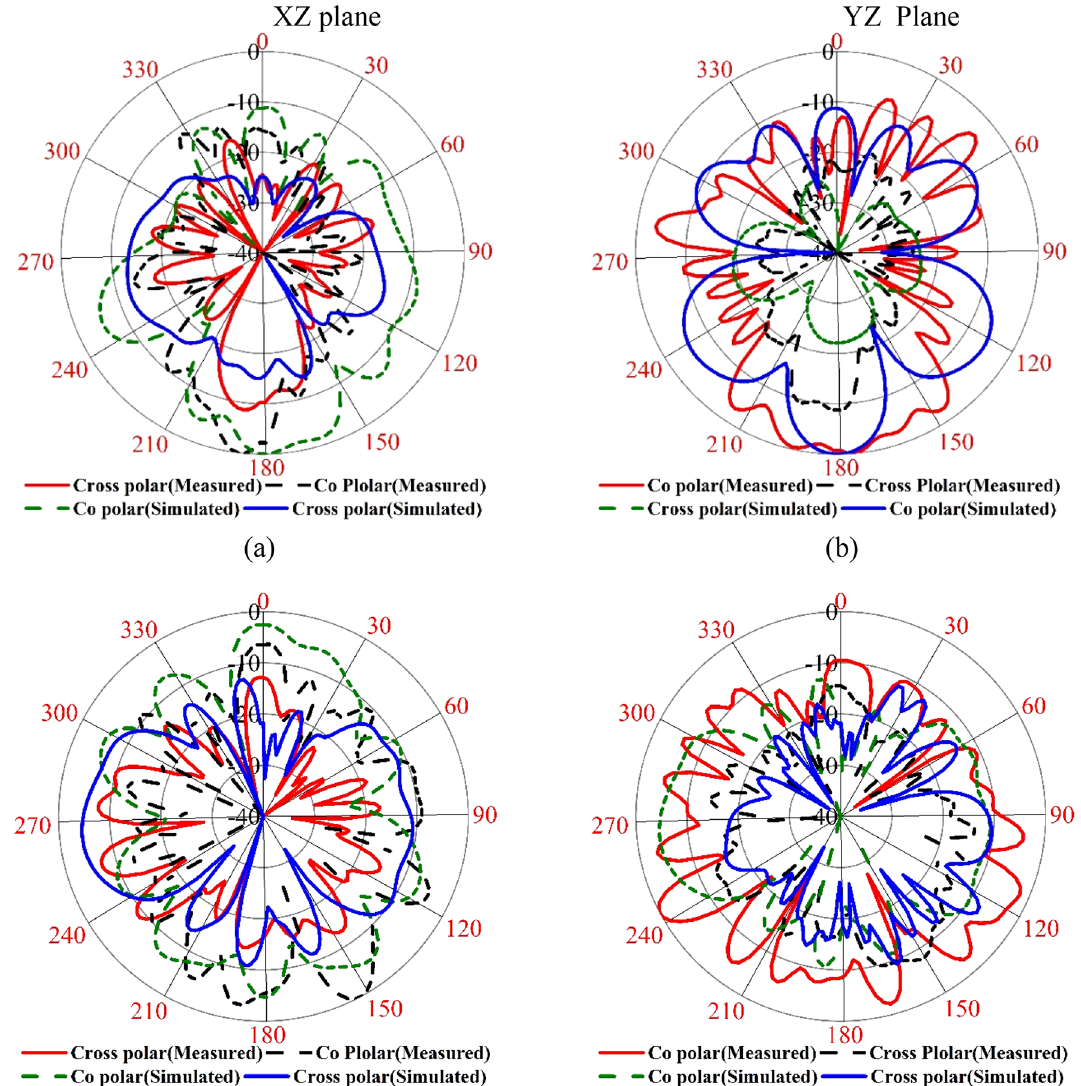
Figure 39. Simulated and measured radiation pattern of the proposed metamaterial with antenna ( a ) 5.5 GHz and ( b ) 11.70